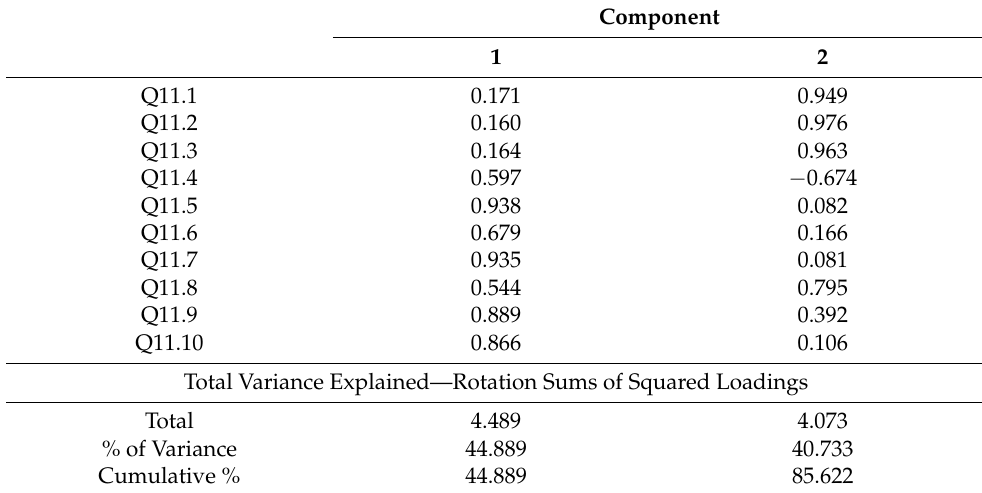
Table A7. Eigenvalues and proportion of the total variance in 9 groups of collective entrepreneurship, as explained by the first three principal components for the original 10 traits and the correlation coefficients between these traits and the first three PCs on for questions